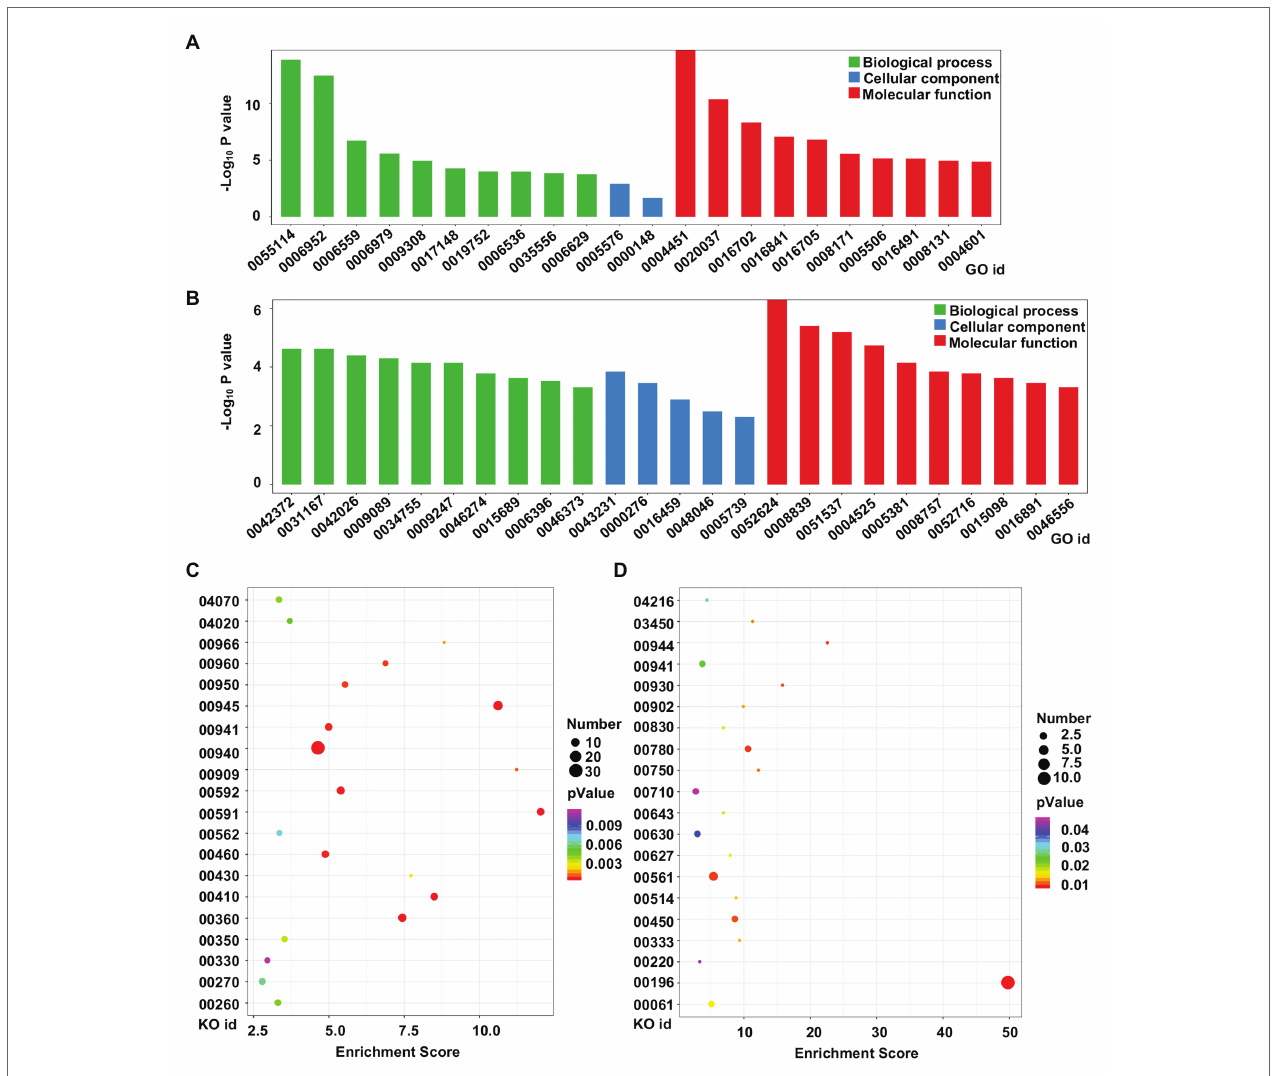
FIGURE 5 | Functional analysis of DEGs between diploid and tetraploid barley. (A) Gene Ontology (GO) analysis of upregulated genes; (B) GO analysis of downregulated genes; (C) Kyoto Encyclopedia of Genes and Genomes (KEGG) analysis of upregulated genes; (D) KEGG analysis of downregulated genes. For the GO ids, 0055114: oxidation-reduction process; 0006952: defense response; 0006559: L-phenylalanine catabolic process; 0006979: response to oxidative stress; 0009308: amine metabolic process; 0017148: negative regulation of translation; 0019752: carboxylic acid metabolic process; 0006536: glutamate metabolic process; 0035556: intracellular signal transduction; 0006629: lipid metabolic process; 0005576: extracellular region; 0000148: 1,3-beta-D-glucan synthase complex; 0004451: isocitrate lyase activity; 0020037: heme binding; 0016702: oxidoreductase activity, acting on single donors with the incorporation of molecular oxygen, incorporation of two atoms of oxygen; 0016841: ammonia-lyase activity; 0016705: oxidoreductase activity, acting on paired donors, with incorporation or reduction of molecular oxygen; 0008171: O-methyltransferase activity; 0005506: iron ion binding;